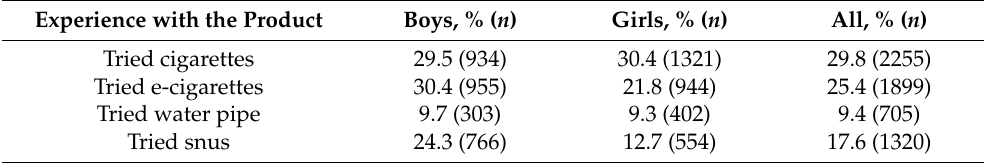
Table 1. Percentage (%) of adolescents who had tried cigarettes, e-cigarettes, snus, and water pipe, by gender.